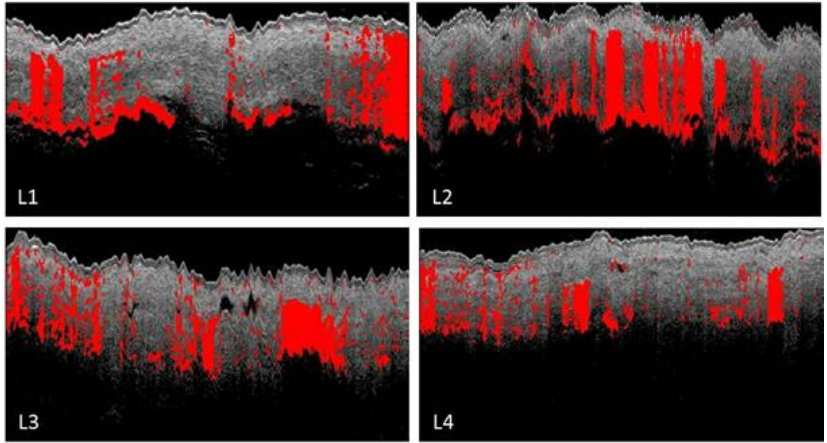
Figure 8. Normalized percentage of pixels per patient per location obtained from the OCT M ‐ mode scans. The values are normalized relative to location 1, hence only the plots for patients with a value for location 1 are